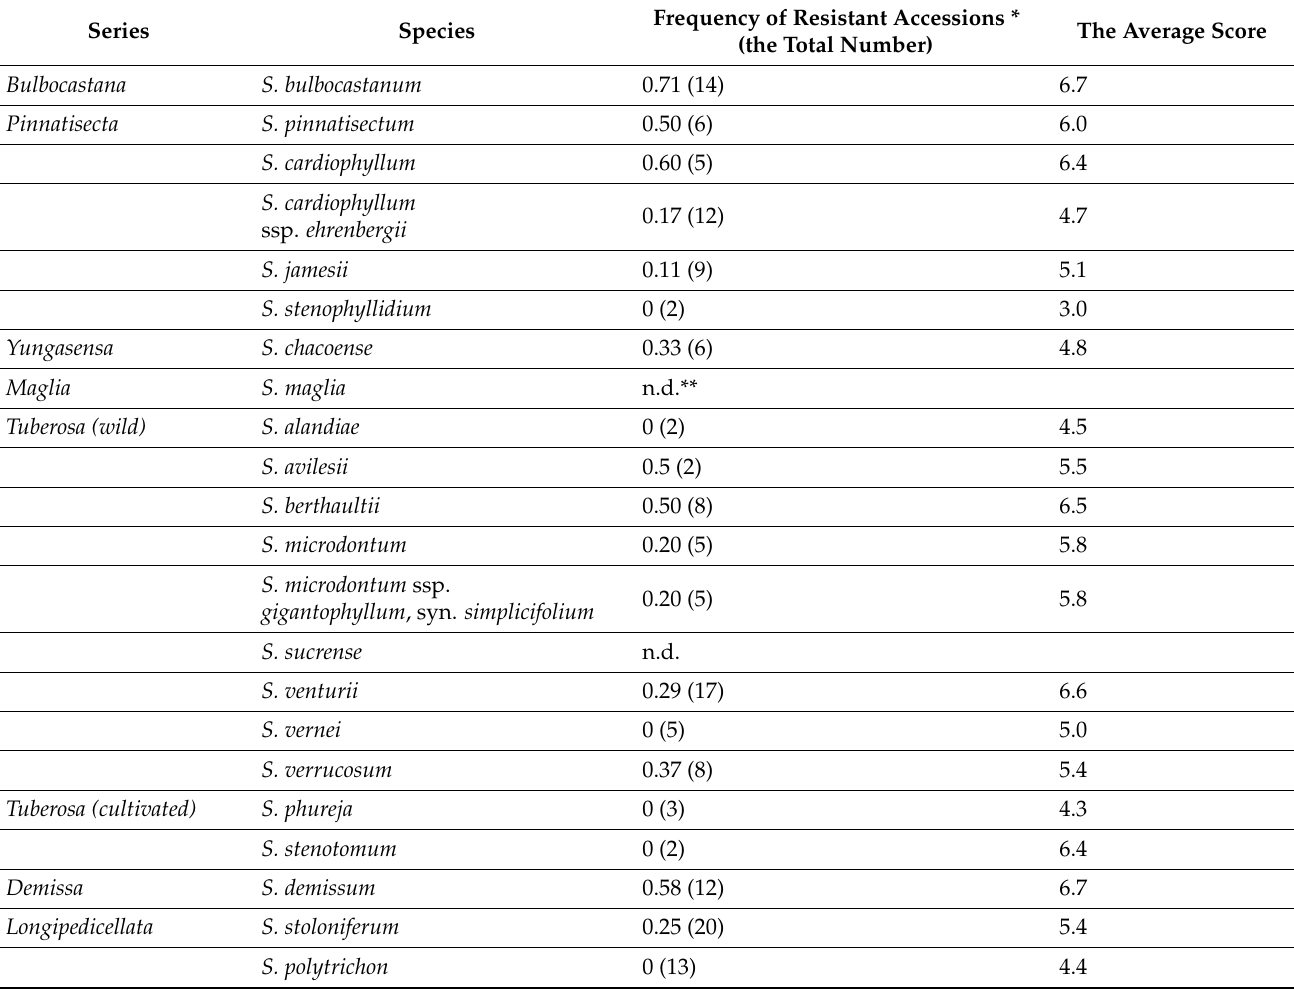
Table 1. Resistance of wild potato species accessions to P. infestans in the laboratory